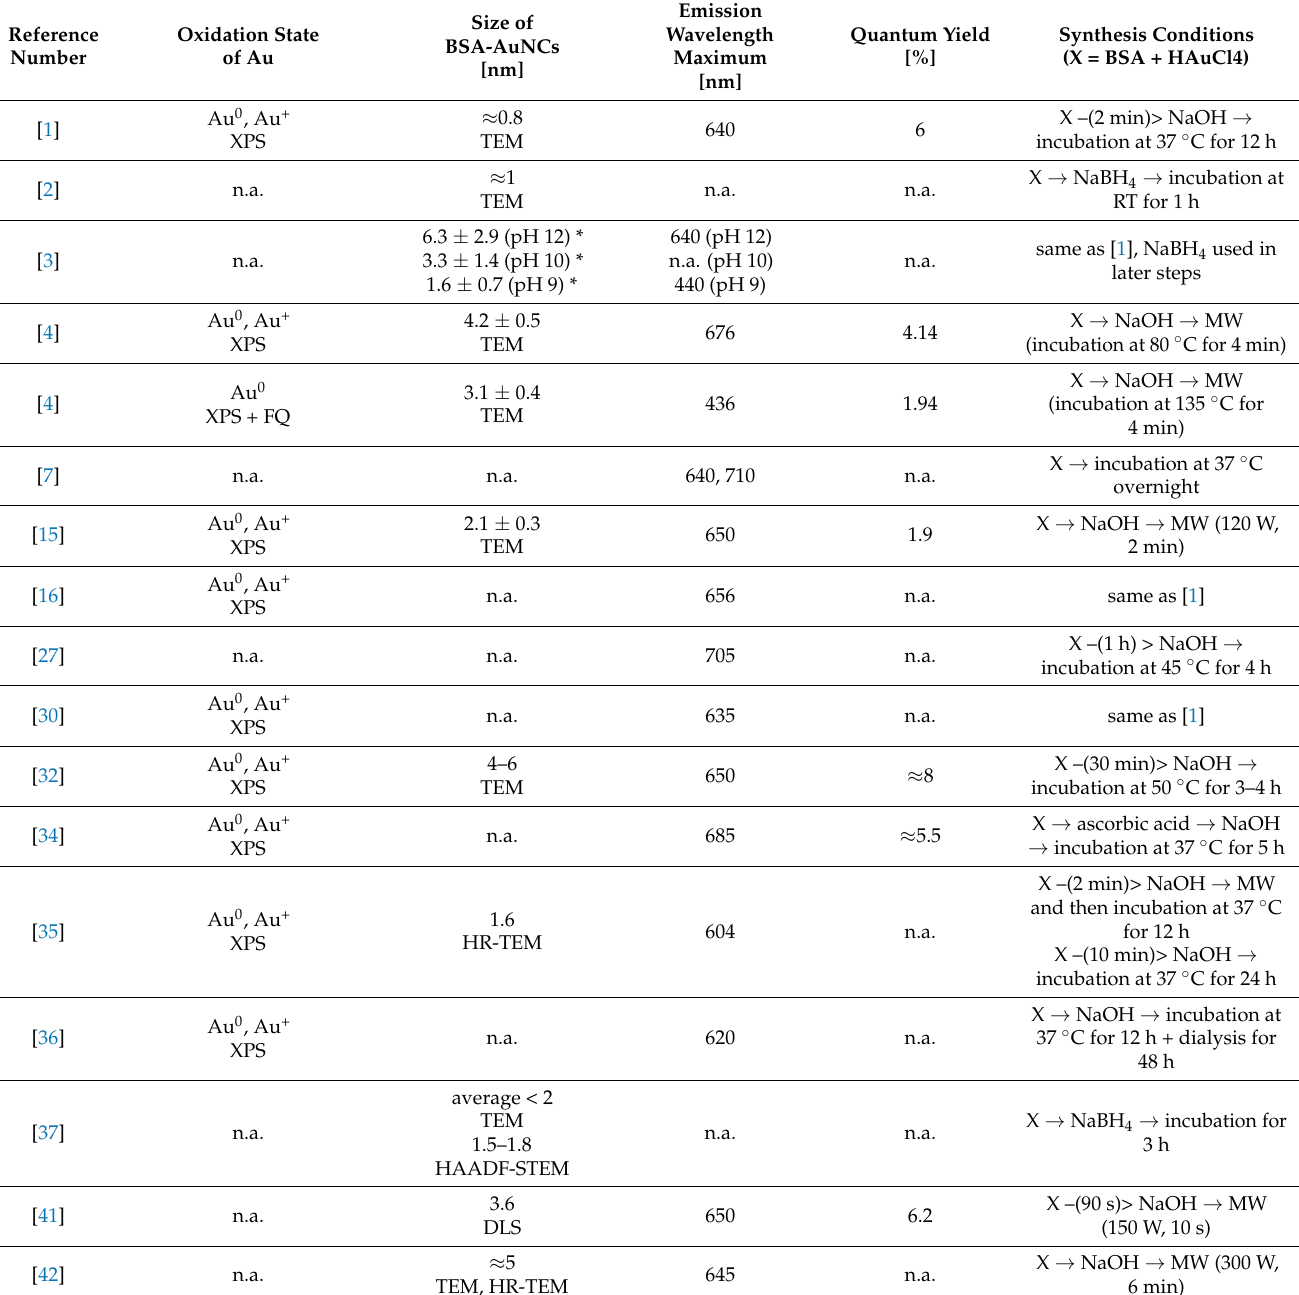
Table 1. Details of selected BSA-AuNCs preparations and properties as reported in